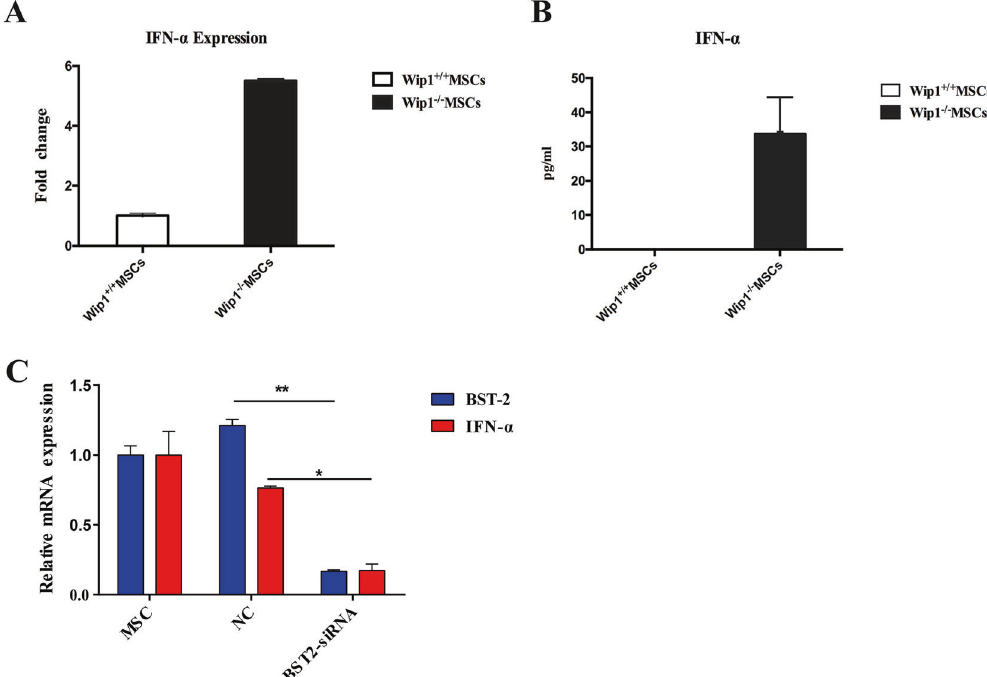
Fig. 5 BST2 promotes IFN – α expression in Wip1 − / − MSCs. A , B The mRNA and protein levels of IFN- α in Wip1 + / + MSCs and Wip1 − / − MSCs were detected by qPCR and ELISA. C Wip1 − / − MSCs were transfected with BST2 siRNA, and the mRNA level of BST2 and IFN- α in Wip1 − / − MSCs were measured by qPCR 48 h after transfection. Three independent experiments, * P < 0.05, ** P <